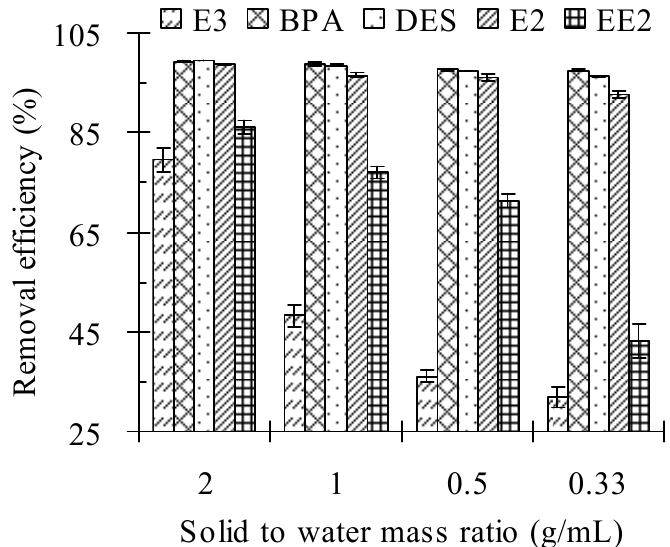
Figure 3. Effect of the solid to water mass ratio on the removal efficiency of estrogens from cow manure by the Fenton oxidation process. Note: Fe(II) to H 2 O 2 molar ratio = 0.10 M/M; H 2 O 2 dosage = 2.56 mmol/g; initial pH values = 3.0; reaction time = 24 h. Error bars are standard deviations.